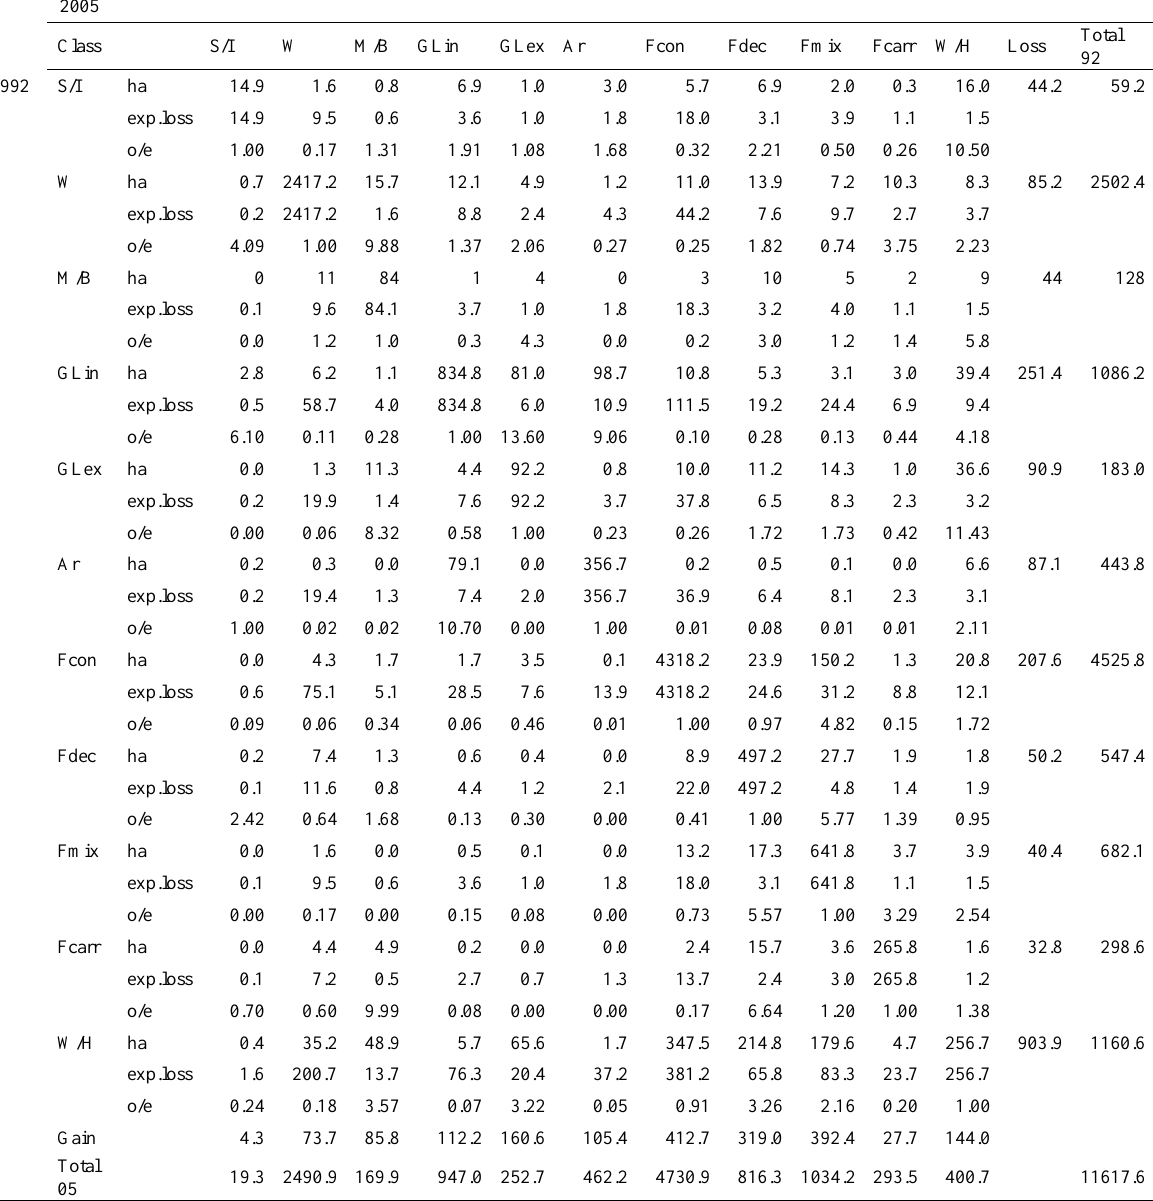
Table A1.4: Buffer